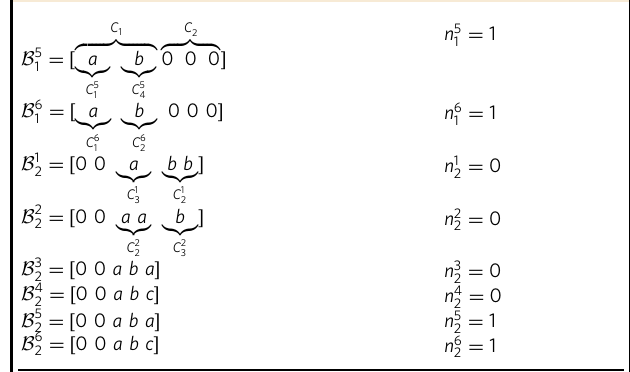
Breaking vectors B j q and corresponding intertwining indices n j q for each partition P j and for the equitable clusters C 1 and C 2 of the network of Fig. 2, partition P . For the fi rst four breaking vectors also the broken clusters are shown. Cluster C 1 is broken only in partitions P 5 and P 6 (see the fi rst two rows and Fig. 2). In P 5 (see Fig. 2), C 1 is broken as described in the fi rst